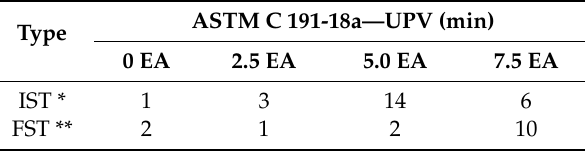
Table 4. Di ff erences in setting time between the ASTM C 191-18a test method and